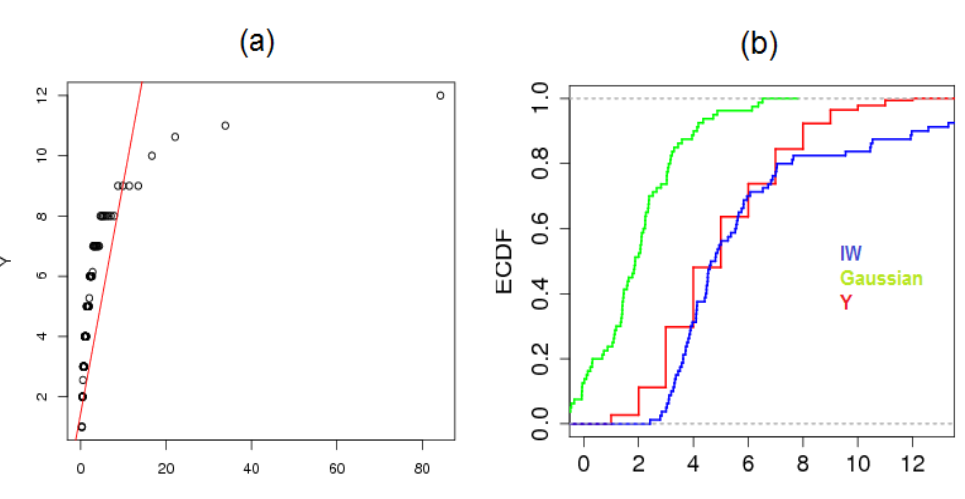
Figure 3. ( a ) Q-Q plots of the wind speed ( Y ) based on IW distribution and ( b ) The ECDF plot of Y based on IW and some other distributions.